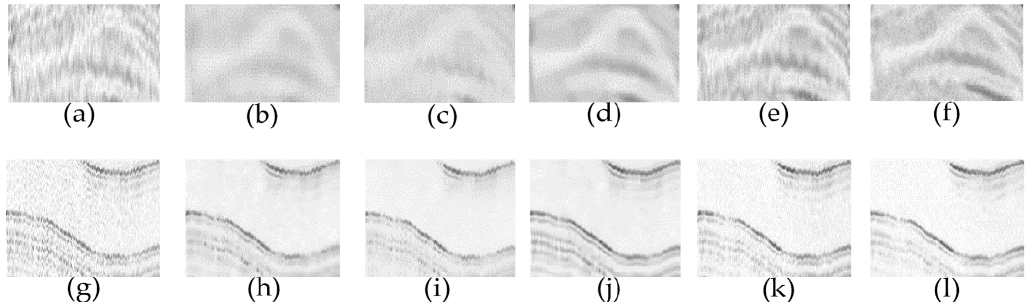
Figure 10. Filtering results: ( a ) is the details of the area in the lower rectangle in Figure 9a, ( b – f ) show the details of filtered results in the lower rectangle in Figure 9 using KSVD, NLM, BM3D, NLLR, and the proposed method, ( g ) is the details of the area in the top rectangle in Figure 9a, ( h – l ) are the details of filtered results in the top rectangle using KSVD, NLM, BM3D, NLLR, and the proposed method. Another test dataset was downloaded from the open dataset [27]. The data was surveyed in the Gulf of Mexico with the sub-bottom profiler named EdgeTech 2200 M. The survey area has a water depth of about 1000 m. To carry out this measurement, an Autonomous Underwater Vehicle (AUV) has been used. The data quality is good, and the layering structures are displayed well. However, the scattering echoes in the sediment interior may bring difficulties to the following auto-processing, such as horizon picking and sediment classification. Different methods were applied to this denoising task and comparisons were made. KSVD and BM3D, as well as NLM preserved the layering structures well, however, the noise has not been removed well. BM3D generated some fake structures which were introduced into the filtered results, as shown in the area marked with red rectangles in Figure 11d. The NLLR method removed most of the noise, though there is still residual noise, as shown in the area marked with a red rectangle in Figure 11e. Thanks to the guidance weight constraint and the vertical constraint, our results removed noise well, as shown in Figure 11f. What is more, applying vessel enhancement filtering to the complementary image IM ´ improved the performance of our method in sediment interior noise reduction.